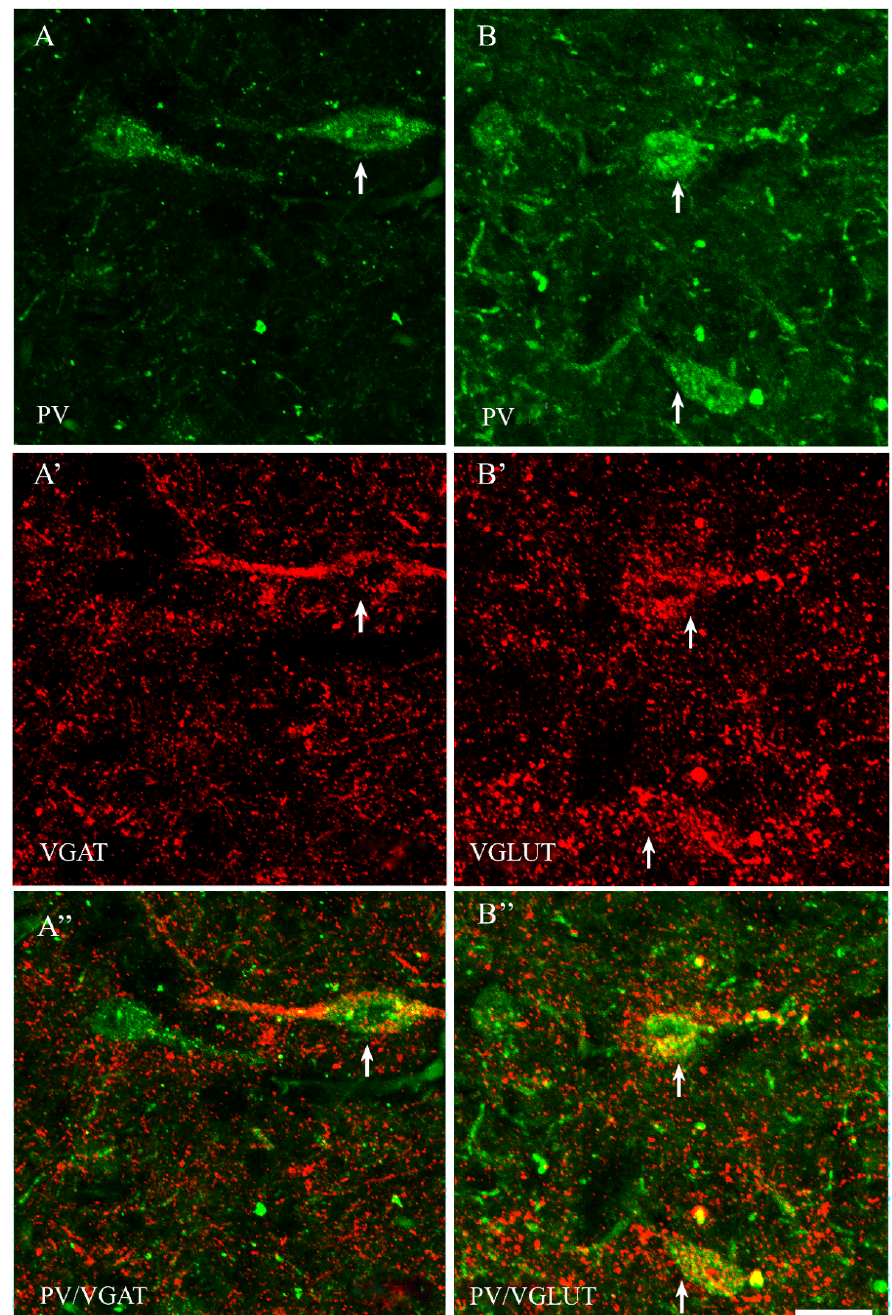
Figure 6. Double-labeling confocal immunofluorescence illustrating the anatomical relationships between PV+ neurons and VGAT ( A – A” ) as well as PV+ neurons and VGLUT ( B – B” ) in the medial preoptic area of the guinea pig. Arrows show PV+ neurons that were simultaneously VGAT+ ( A – A” ) and/or VGLUT+ ( B – B” ). Scale bar = 20 μ m.